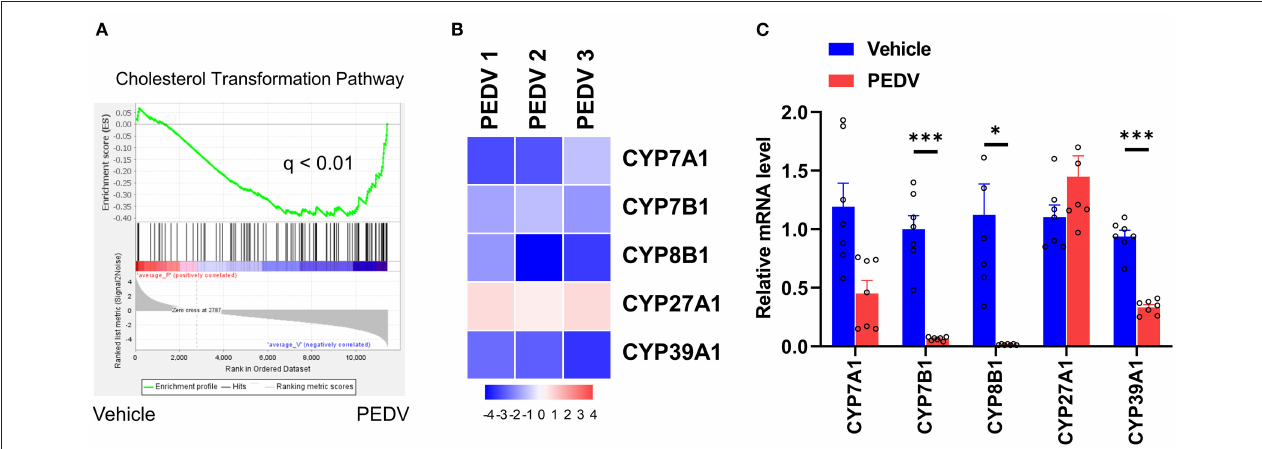
FIGURE 5 | The expression pattern of genes involved in the cholesterol transformation pathway. (A) GSEA plots depicting the enrichment of genes in the cholesterol transformation pathway of livers from PEDV-infected piglets compared to the controls. FDR, false-discovery rate. (B) Heatmap of mRNA expression (RNA-seq) changes of the genes involved in cholesterol transformation to bile acids in the livers of PEDV-infected piglets (log2 transformed, normalized to Control). (C) The qRT-PCR analysis confirmed expression changes of genes in the cholesterol transformation pathway in the livers of PEDV-infected piglets. The data are shown as the means ± SEM, * P < 0.05, *** P < 0.001, using the two-tailed Student t -test.